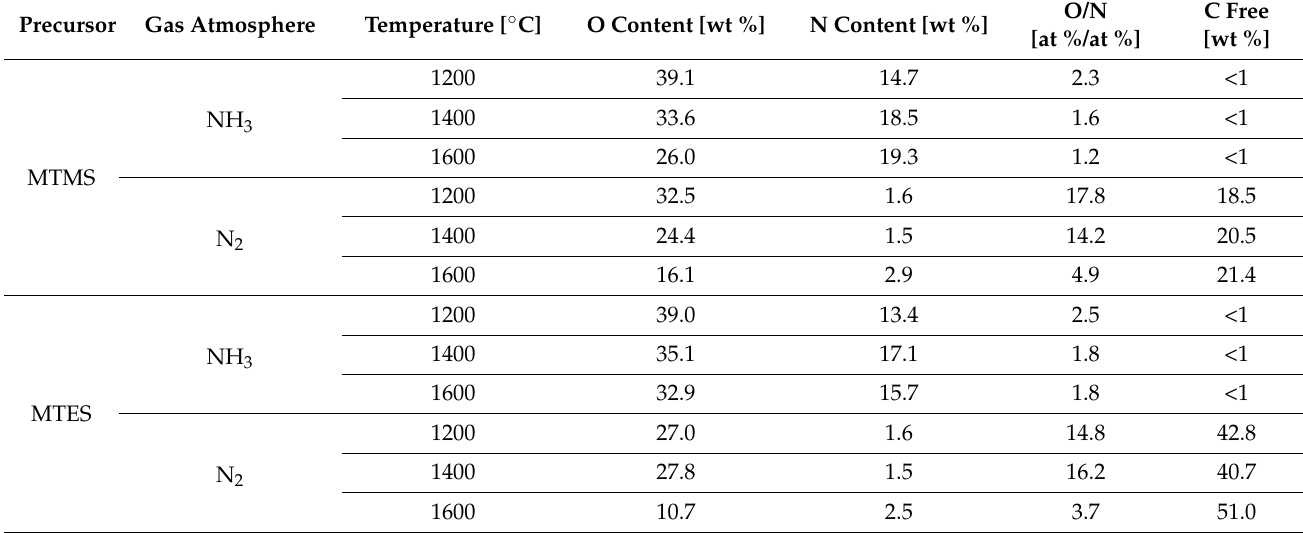
Table 1. The O- and N-contents directly determined in powders produced from MTMS and MTES. The far-right column shows free C-contents determined by mild oxidation in air. Note that O/N ratios are calculated for derived respective atomic